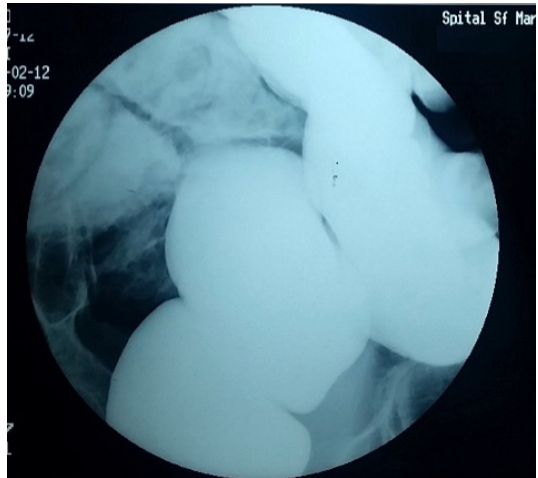
Figure 5. Significant rectal dilation.